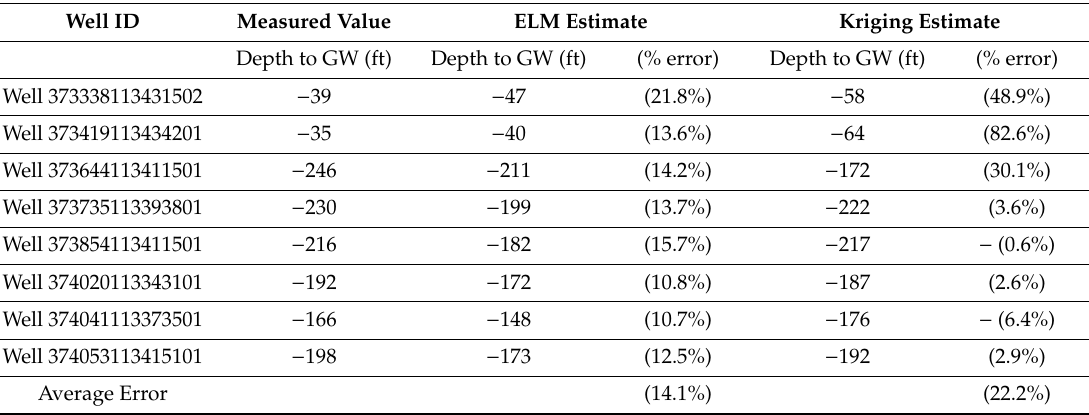
Table 4. Comparison of ELM Error to Kriging Error for Wells in the Beryl-Enterprise Area. The comparison is made using data from 1 December